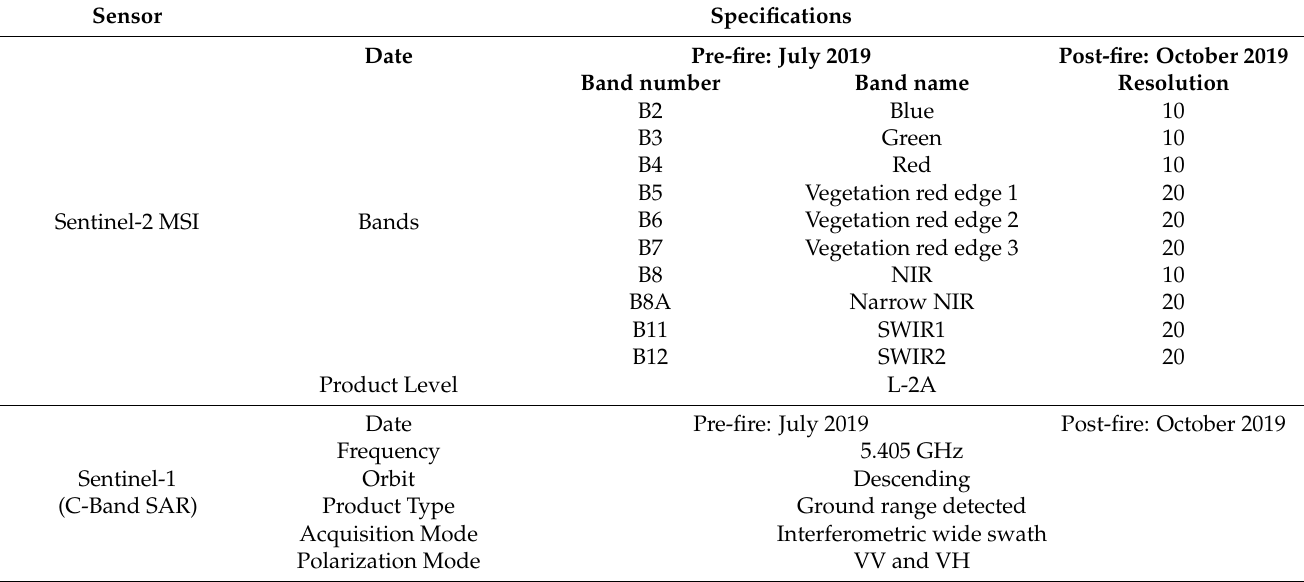
Table 1. Specifications of Sentinel-1 and Sentinel-2 data used in the research